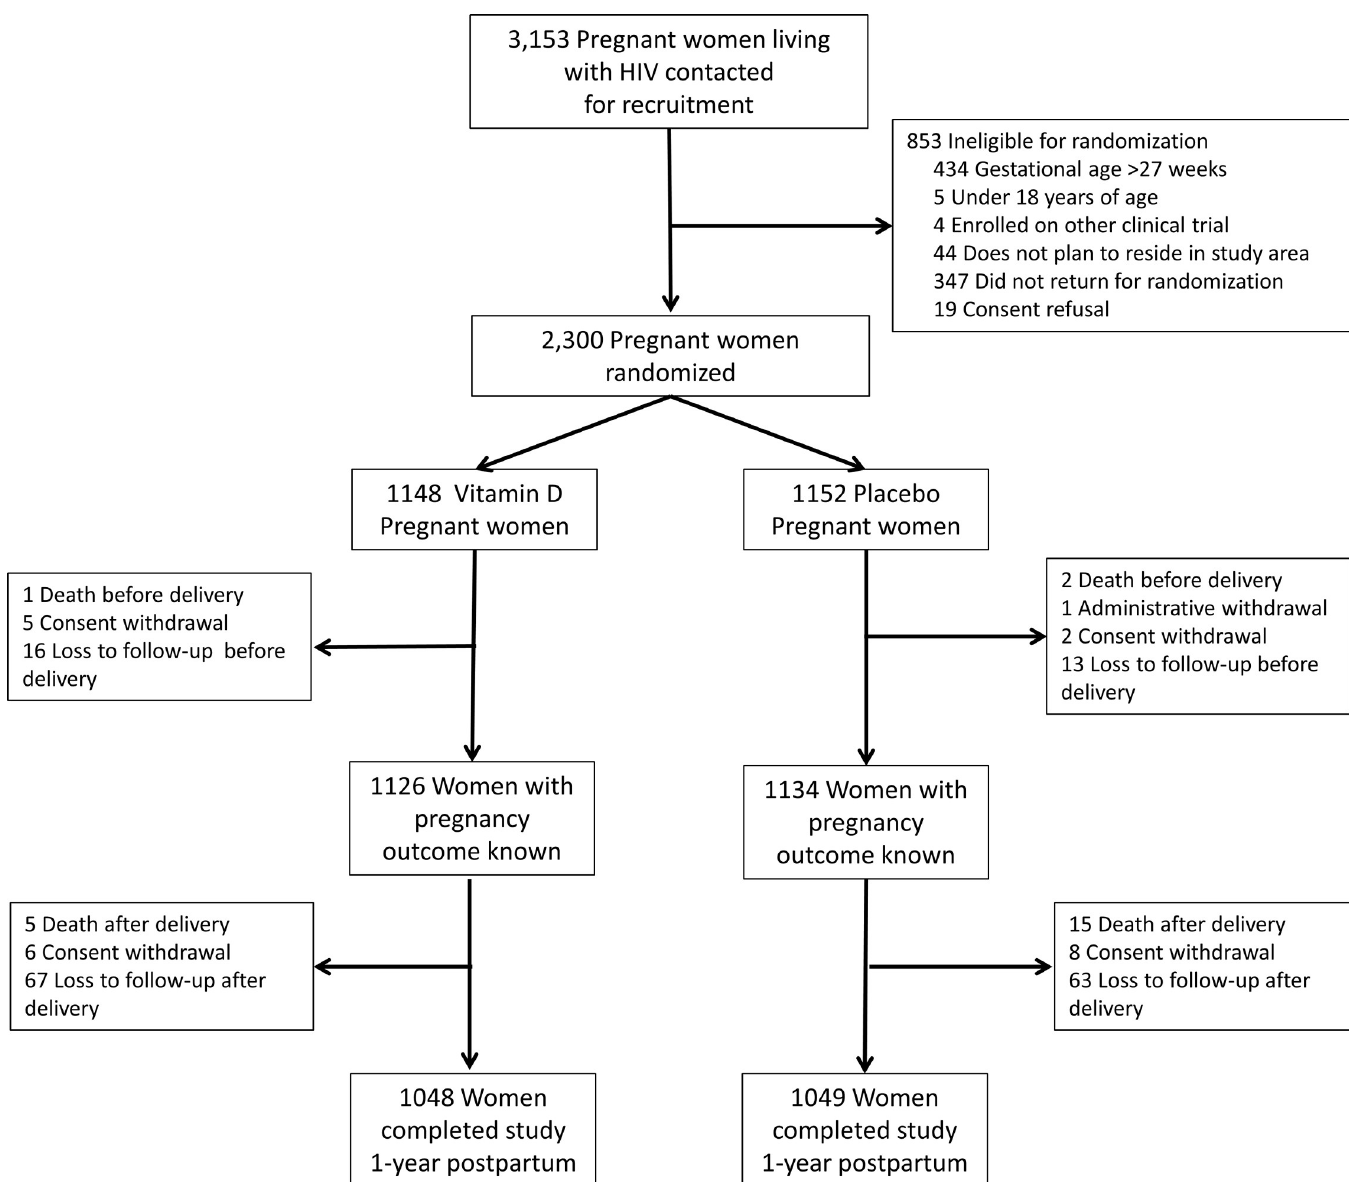
Fig 1. Trial flow diagram for